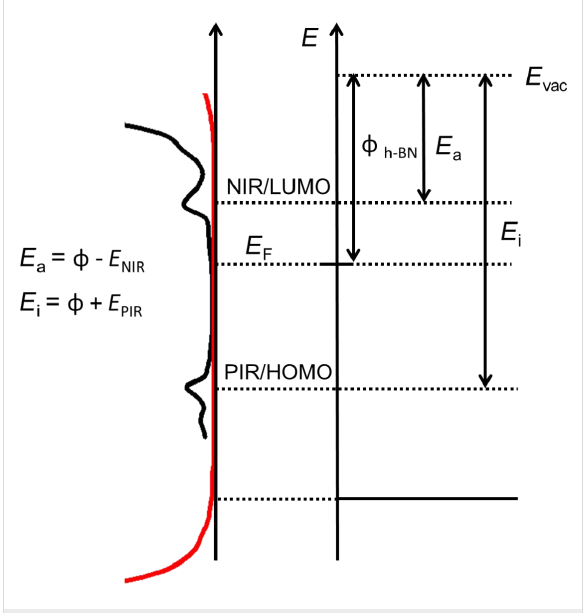
Figure 6: Energy-level diagram depicting the relations between E a , E i , Φ and the energies measured in STS for the HOMO and the LUMO of